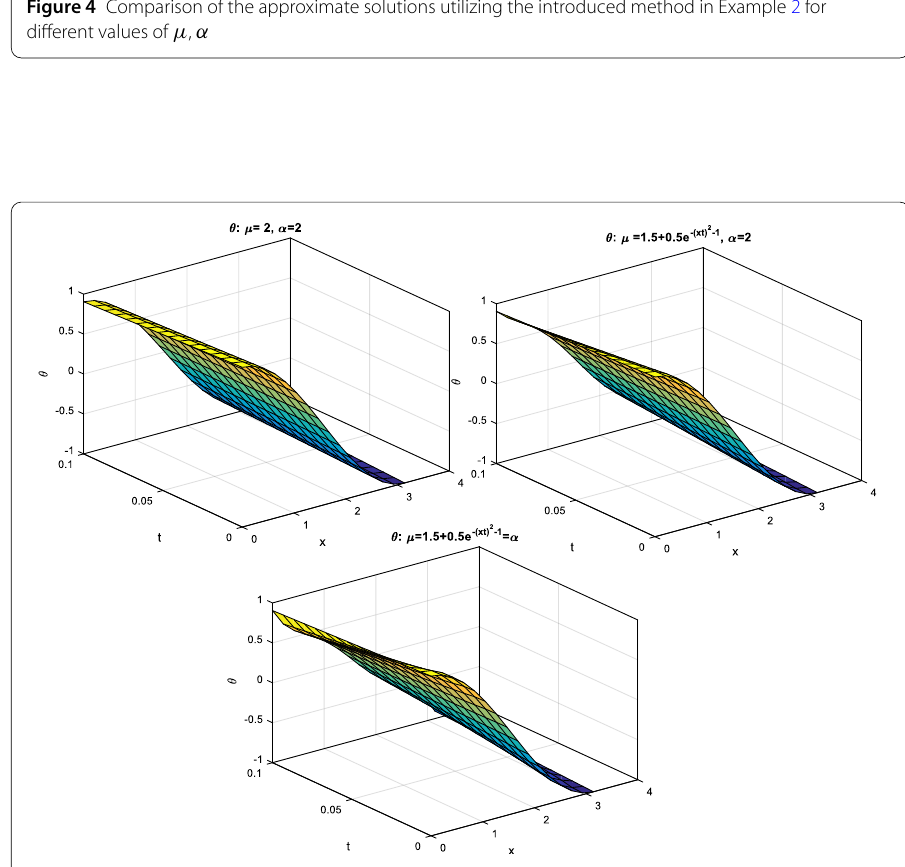
Figure 5 Comparison of the numerical solutions using the introduced method in Example 2 for different values of μ ,